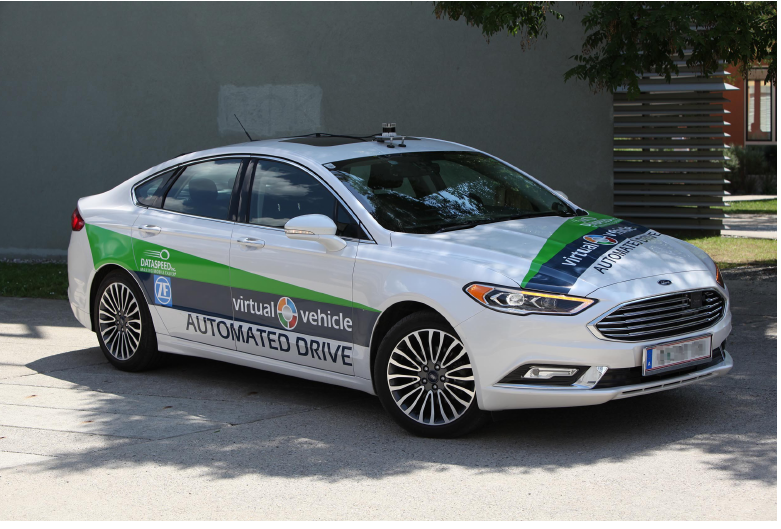
Figure 7. VIF’s Automated Drive Demonstrator (ADD)